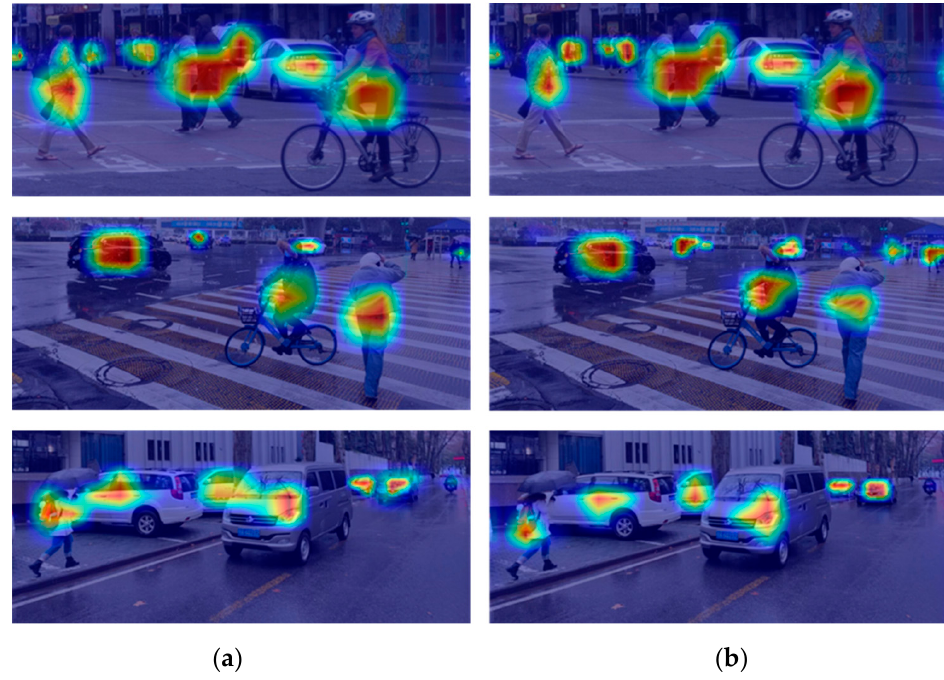
Figure 16. Object detection model inference heat map: ( a ) YOLOv4; ( b )VV-YOLO.